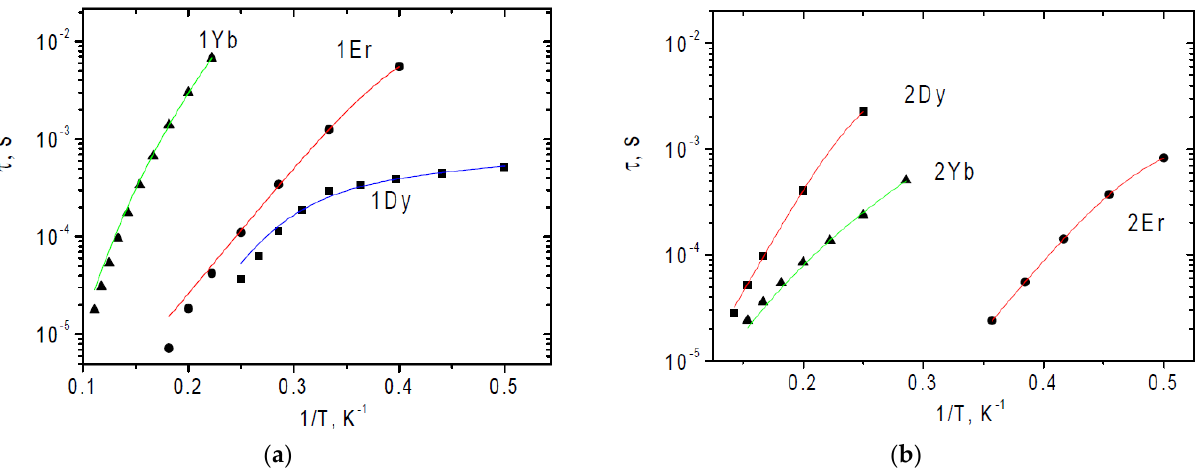
Figure 4. Plots of the τ(1/T) dependences for 1Dy , 1Er , 1Yb ( a ) and 2Dy , 2Er , 2Yb ( b ) in a DC field of optimal intensity. The green lines represent the best approximation by the Raman mechanism (for 1Yb and 2Yb ). The red lines represent the best approximation by the sum of the Orbach and direct mechanisms (for 1Er , 2Dy and 2Er ). The blue line represents the best approximation by the sum of the Raman and direct mechanisms (for 1Dy ).